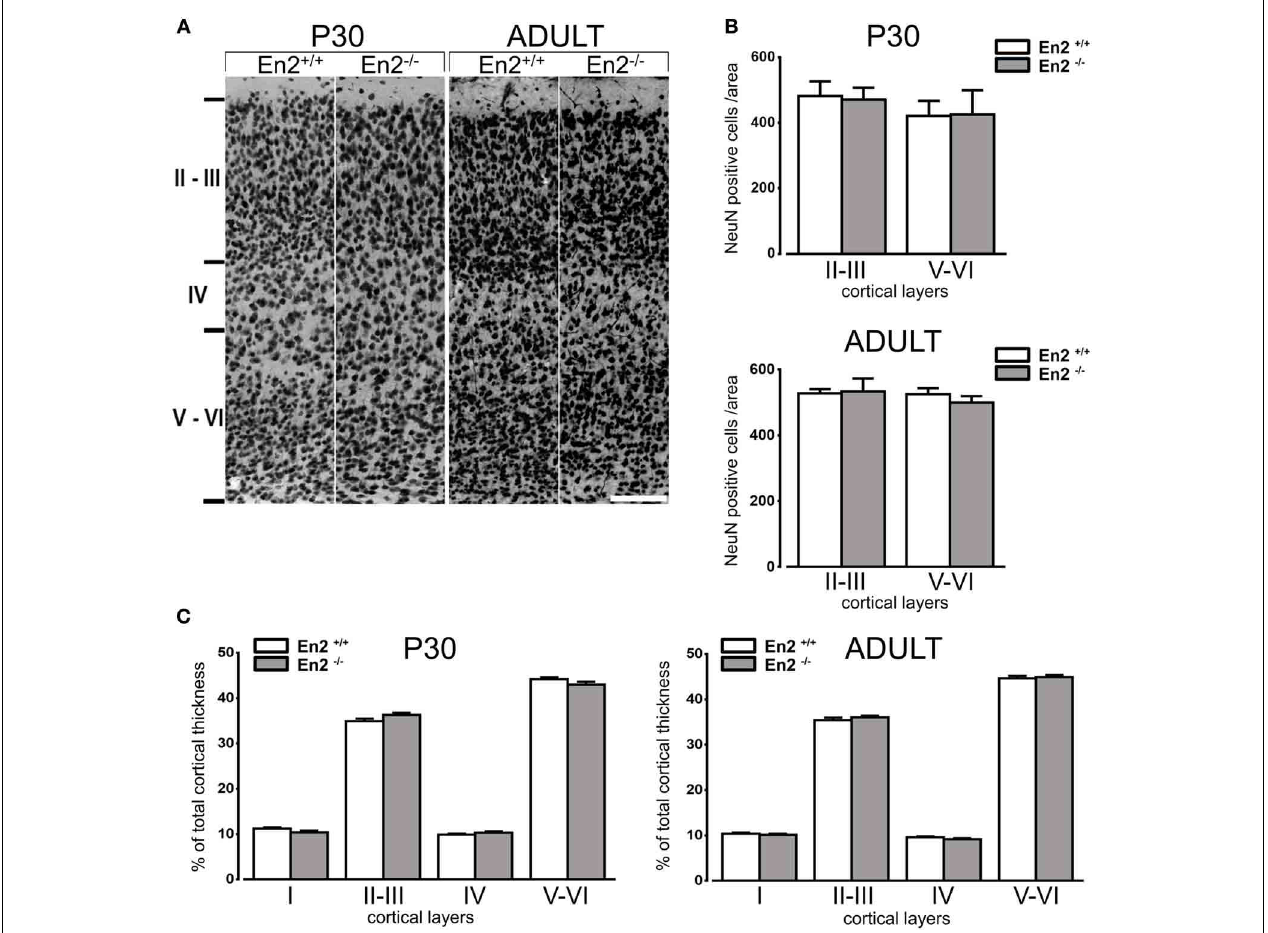
FIGURE 2 | Normal neuronal density and layering in the primary visual cortex of P30 and adult En2 − / − mice. (A) Representative NeuN immunostainingoftheprimaryvisualcortexfromP30andadult En2 + / + (white) and En2 − / − (gray) mice. (B) Quantification of NeuN immunohistochemistry